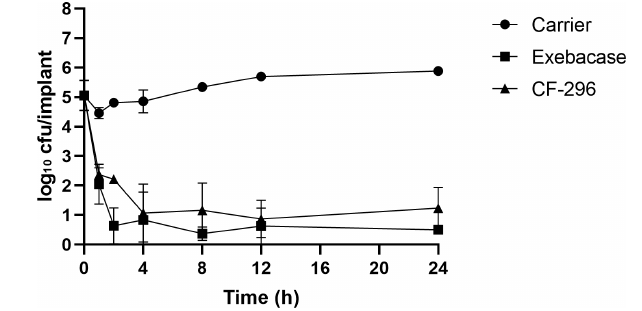
Figure 4. Implant time–kill study. Titanium screws grown overnight with MRSA IDRL-6169 were placed in 0.1mL of lysin carrier, exebacase (10.64mgmL − 1 ), or CF-296 (10.16mgmL − 1 ). After 1, 2, 4, 8, 12, or 24h, three screws each were processed for quantitative culture and results were reported as log 10 cfu per im- plant.